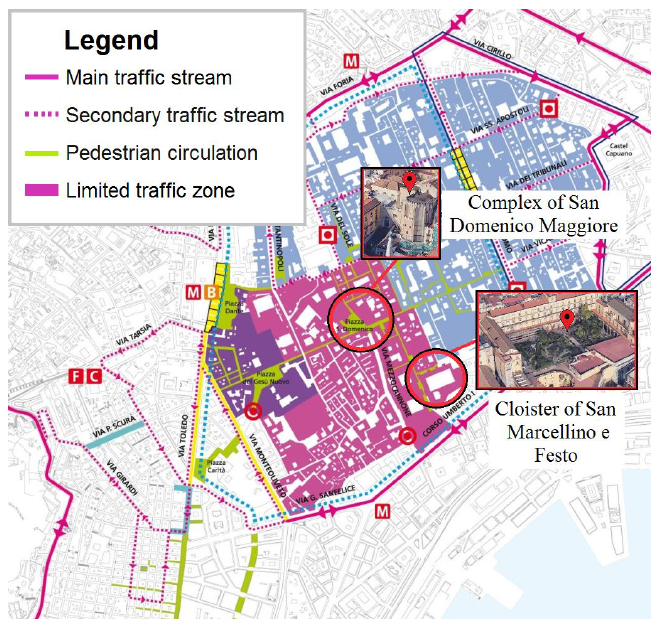
Figure 7. Road map of the urban city center of Naples. The red circle indicates the location of the sampled monuments: SD = Complex of San Domenico Maggiore , SM = Cloister of San Marcellino e Festo .